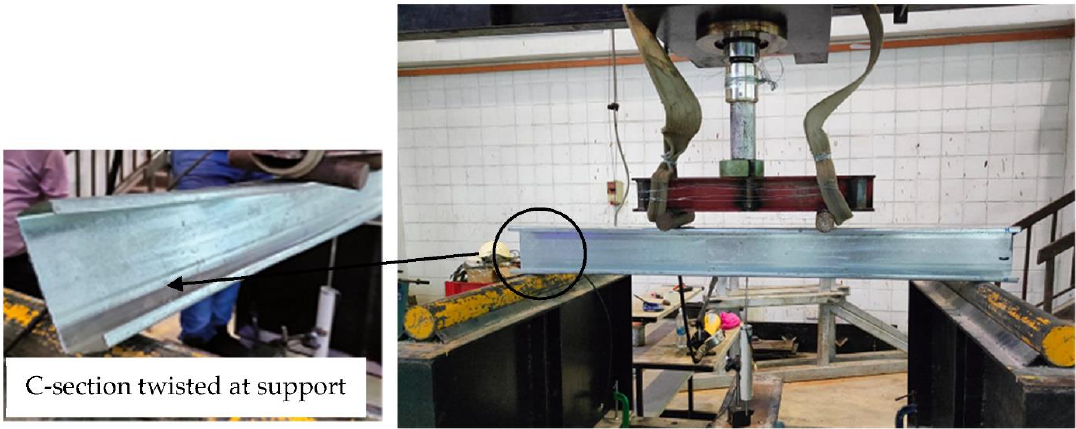
Figure 5. Typical failure modes of hollow C-section specimen.